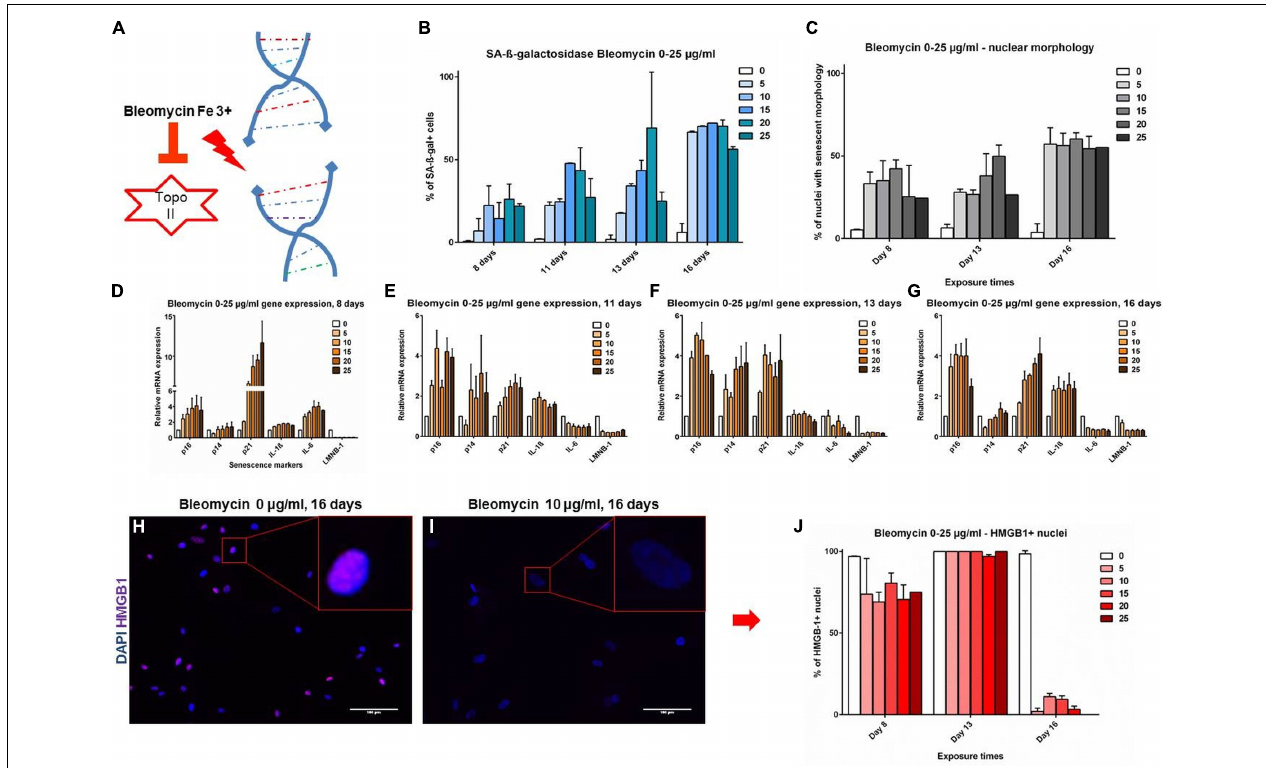
FIGURE 3 | (A–G) Senescence markers in DNA damage-induced senescence. Coronary VSMCs were treated with 0–25 µ g/ml with bleomycin for 3 h and incubated for indicated time-points ( n = 2). (H–J) Immuno-fluorescence of HMGB-1 localization ( n = 2). Topo II- Topoisomerase 2; 0-25- bleomycin doses in µ g per ml; DAPI- 4’,6-diamidino-2-phenylindole; p16, p14, p21- cell cycle inhibitors; IL-1 β , IL-6- interleukins; LMNB-1- Lamin B1; HMGB-1- High mobility group